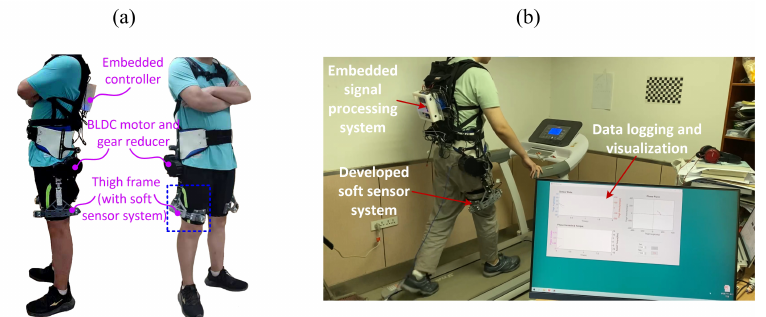
Figure 12. Fabrication of the soft force sensor ( a ), and the characteristic curve of the applied force and output voltage of the force measurement system ( b